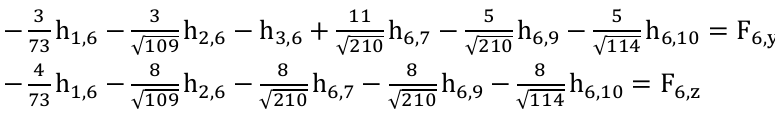
) of the cross sections (𝑆 𝑖 1≤𝑖≤25